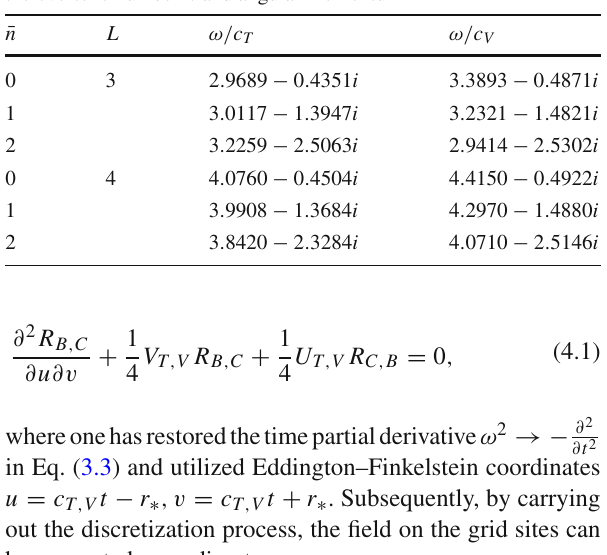
Table 1 The quasinormal frequencies ω/ c T and ω/ c V for the metric parameter m = 0 and n = 1. By employing the third-order WKB approximation, the calculations are carried out using different values of the overtone number ¯ n and angular momentum